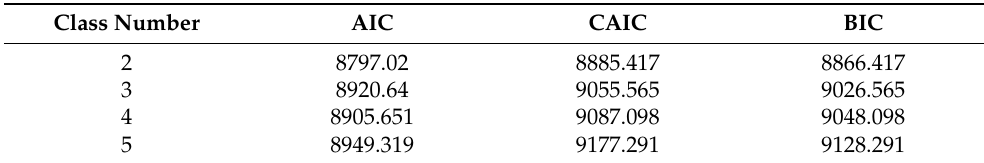
Table 4. Statistical parameters for fit the class number.